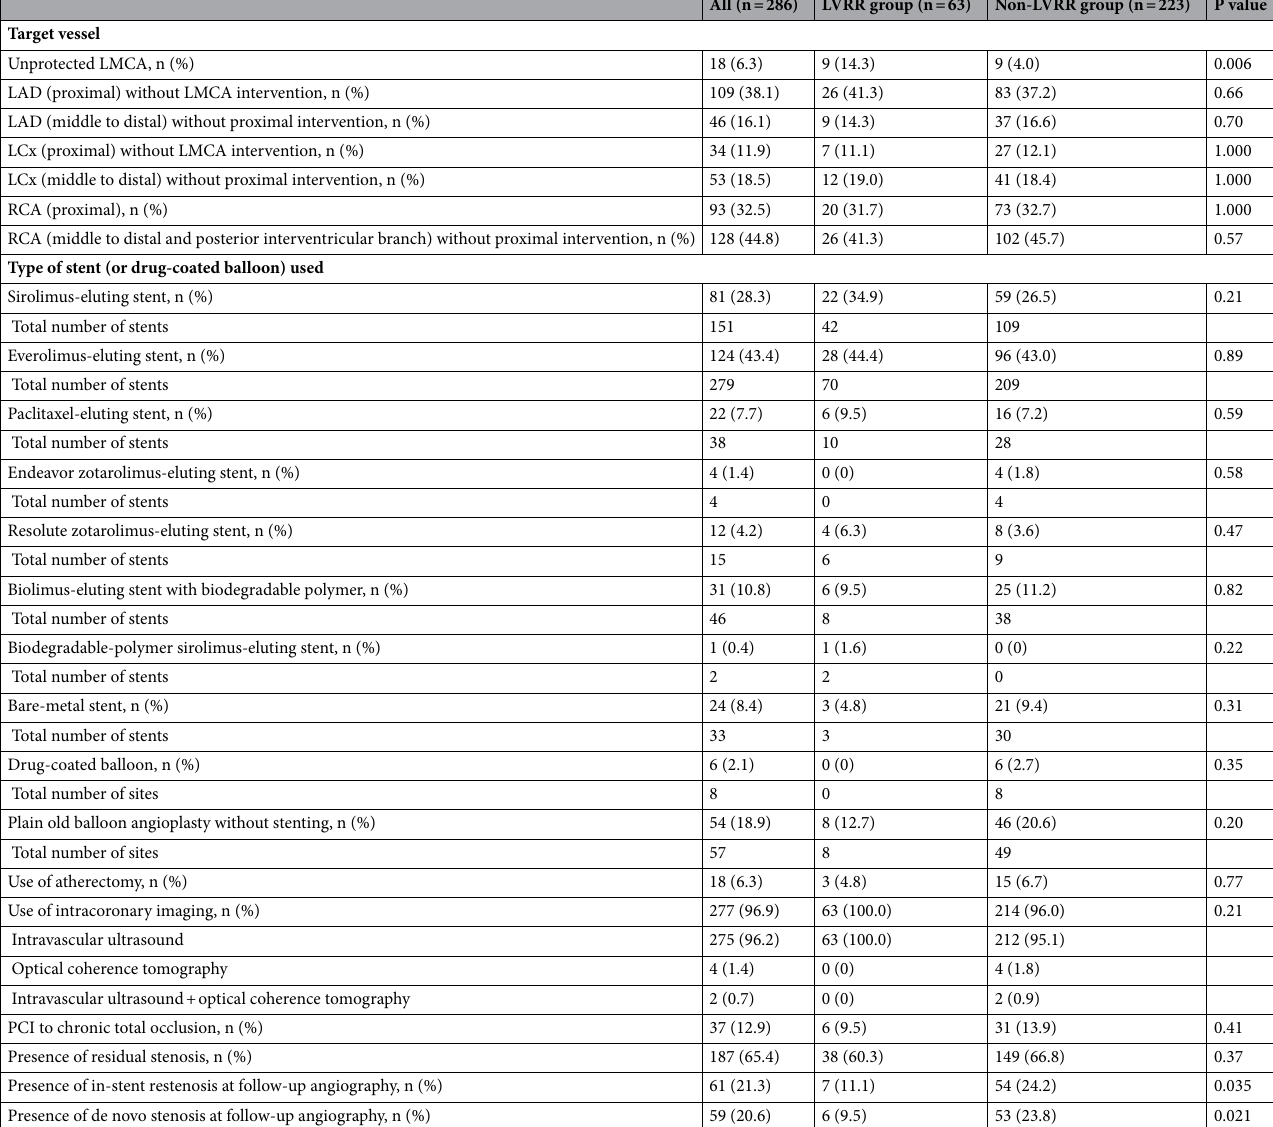
Table 3. Percutaneous coronary intervention. Data are expressed as numbers (%). LMCA left main coronary artery; LAD left anterior descending artery; LCx left circumflex artery; RCA right coronary